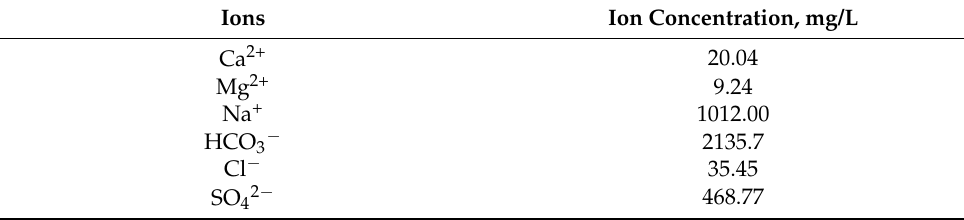
Table 2. Ionic compositions of